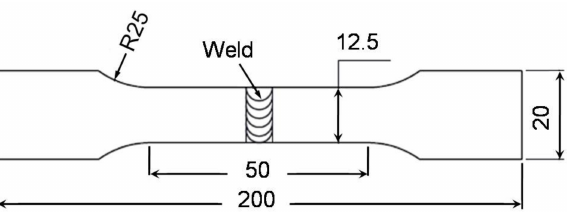
Figure 2. Schematic illustration and dimensions of transverse tensile test specimen of welded joint. Dimensions: mm.